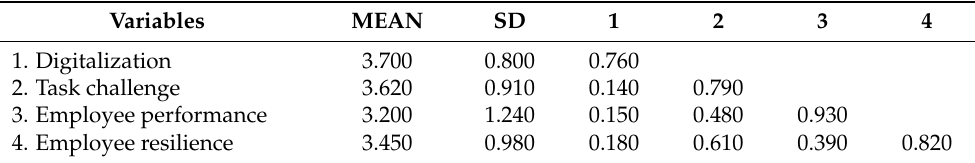
Table 2. Discriminant validity.